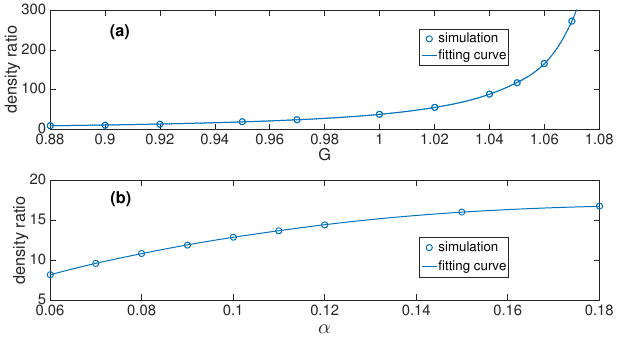
Figure 6. The influence of parameters ( G and α ) on liquid-vapor density ratio: subfigure ( a ) gives the relationship between density ratio and the parameter G ; subfigure ( b ) gives the relationship between density ratio and the parameter α ; the whole field is isothermal with T =